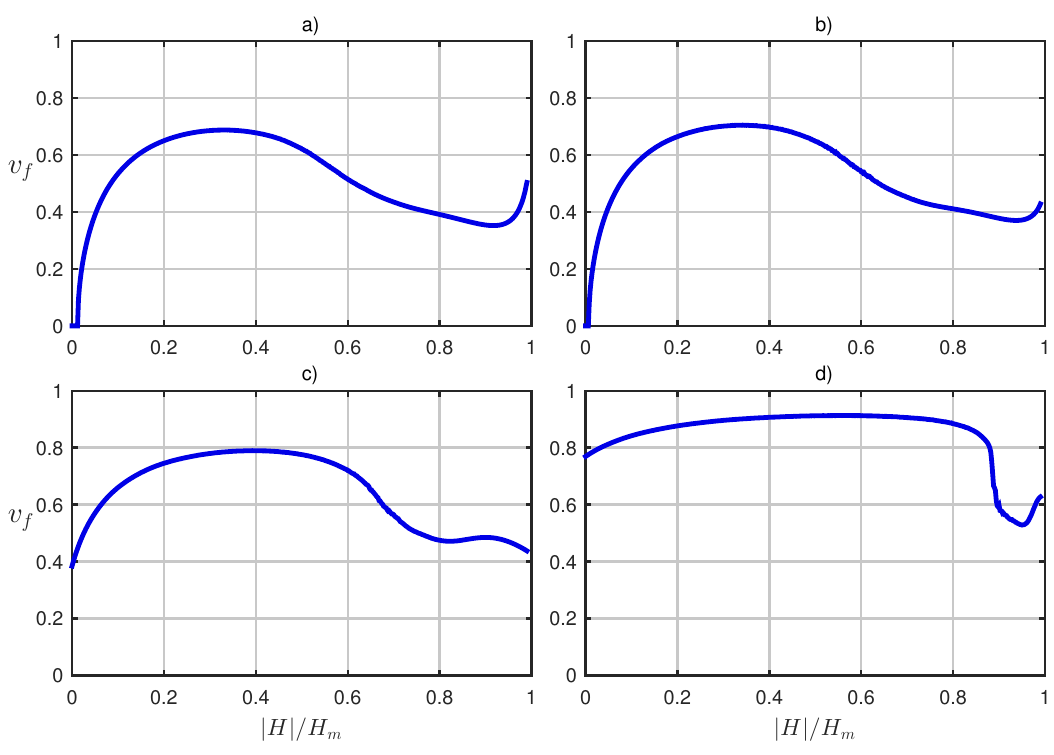
Figure 19 . Final velocity modulus v f of the produced Φ 1 a) v i = 0 . 05 b) v i = 0 . 20 c) v i = 0 . 50 d) v i = 0 .